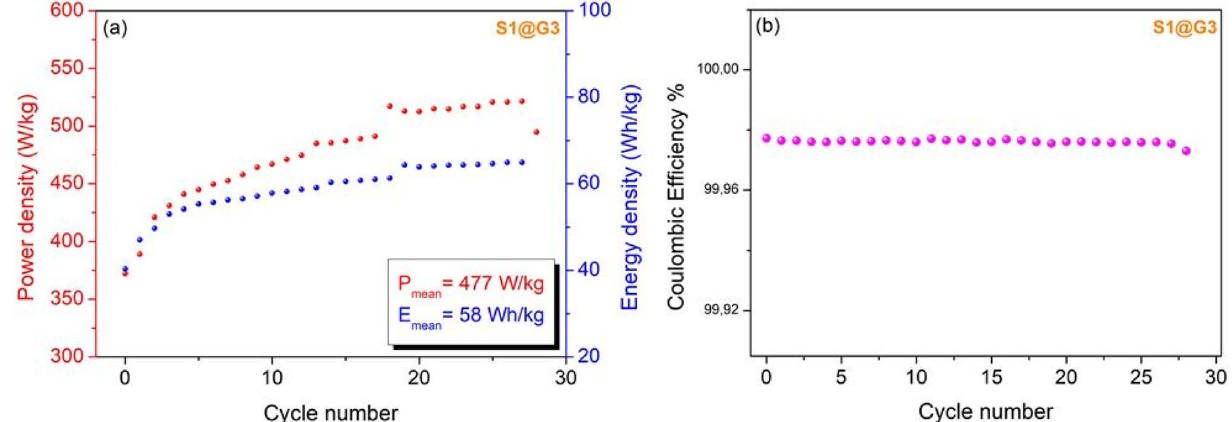
Figure 7. ( a ) Power and energy density, ( b ) Coulombic efficiency for about 30 scans of S1@G3 sample as an electrode. This sample has been synthesized by the graphite and B 2 O 3 as starting materials and the highest defect concentration obtained from